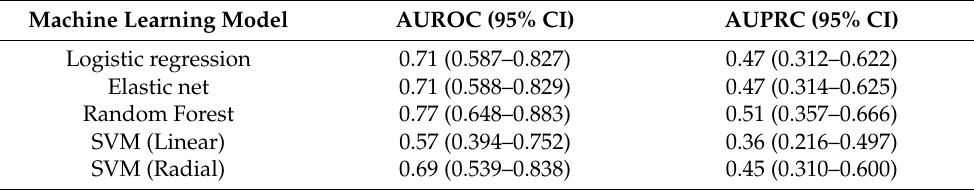
Table 3. Comparisons of AUC for the logistic regression, elastic net, random forest, and SVM models.